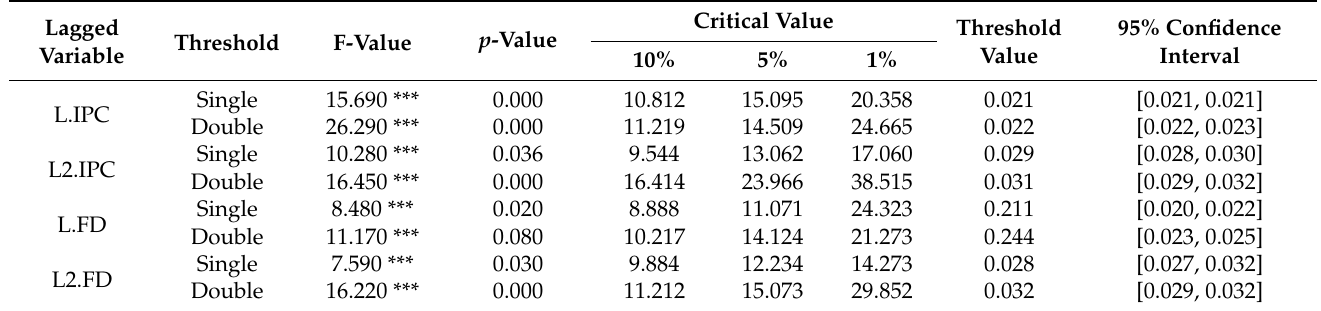
Table 8. Existence test for lagged variable threshold effects.